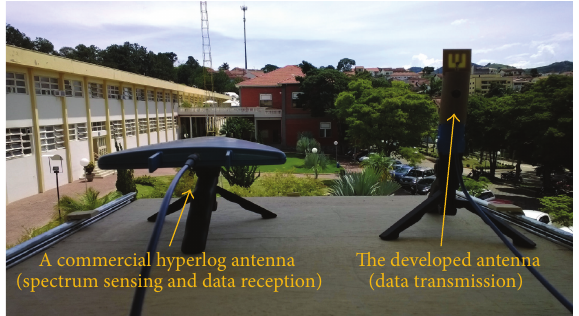
Figure 6: “E”-shape and Hyperlog antennas.